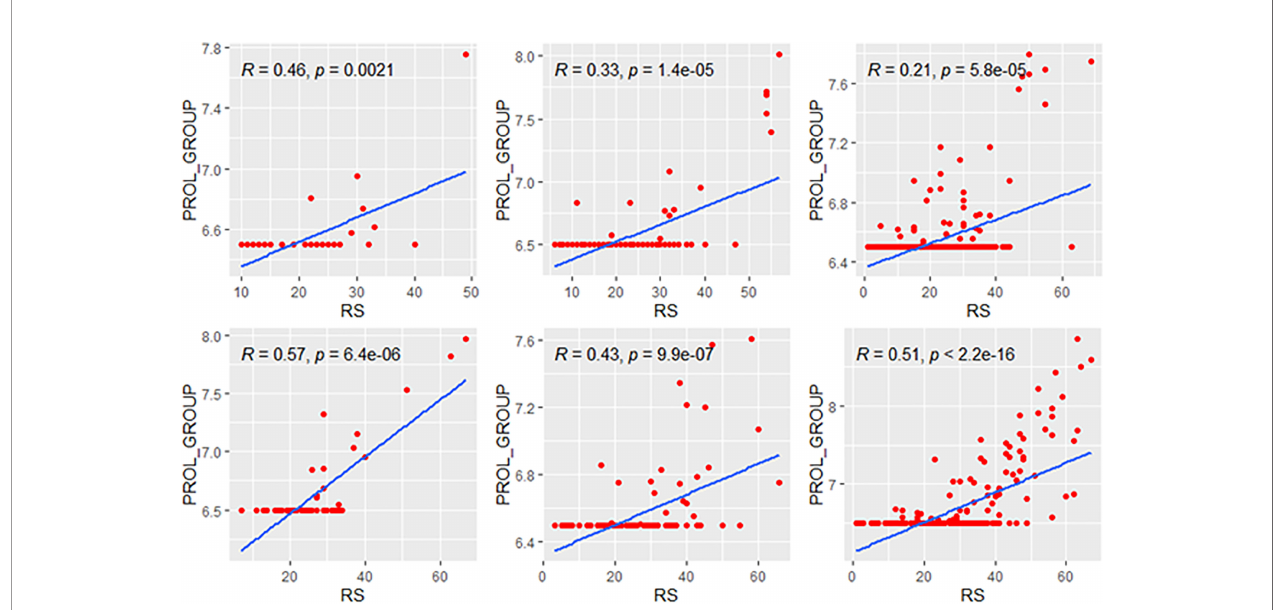
FIGURE 7 | Relationships of the RS with its proliferation module. The upside and downside ranks showed the relationship in patients with low and high clinical risk respectively. Groups A, B, and C were presented from left to right. RS, recurrence score; PROL,